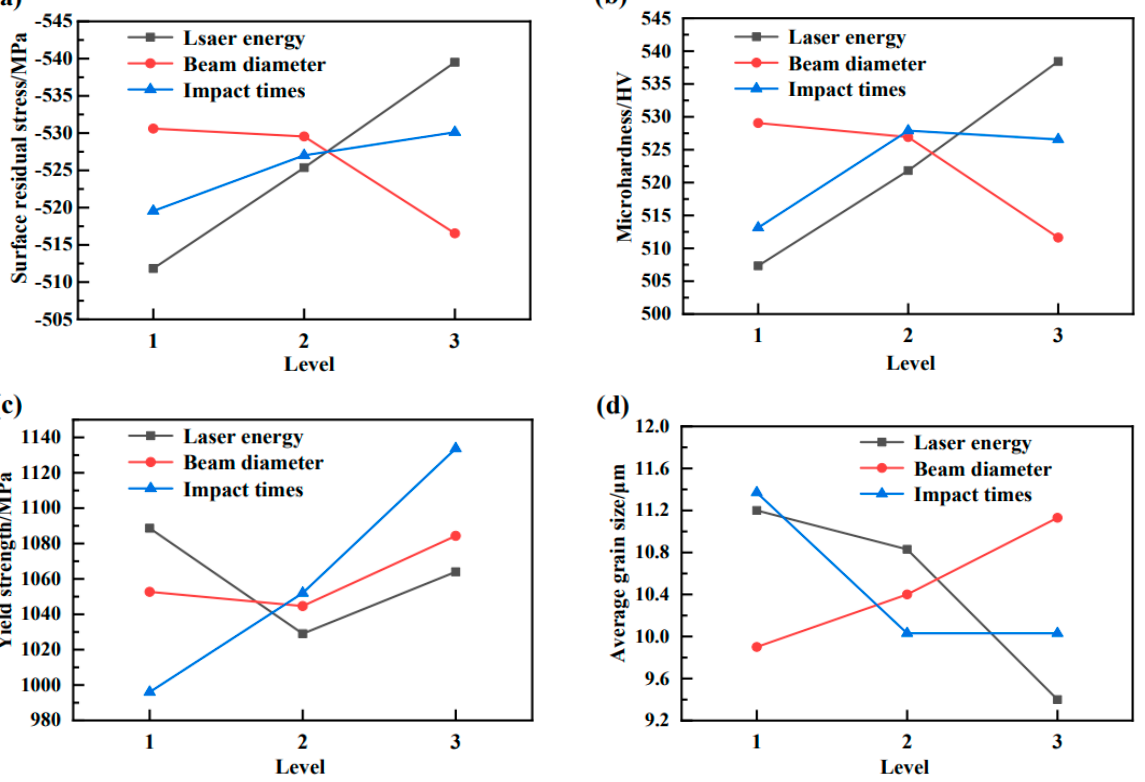
Figure 5. The variation trends of different performance indicators for each factor. ( a ) The variation trend of surface residual stress; ( b ) the variation trend of microhardness; ( c ) the variation trend of yield strength; ( d ) the variation trend of average grain